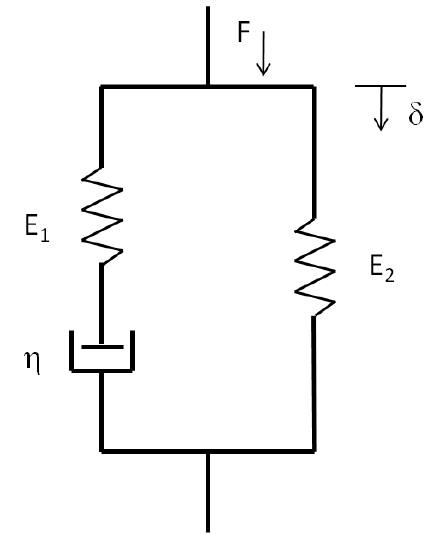
Figure 5. The linear solid standard model.